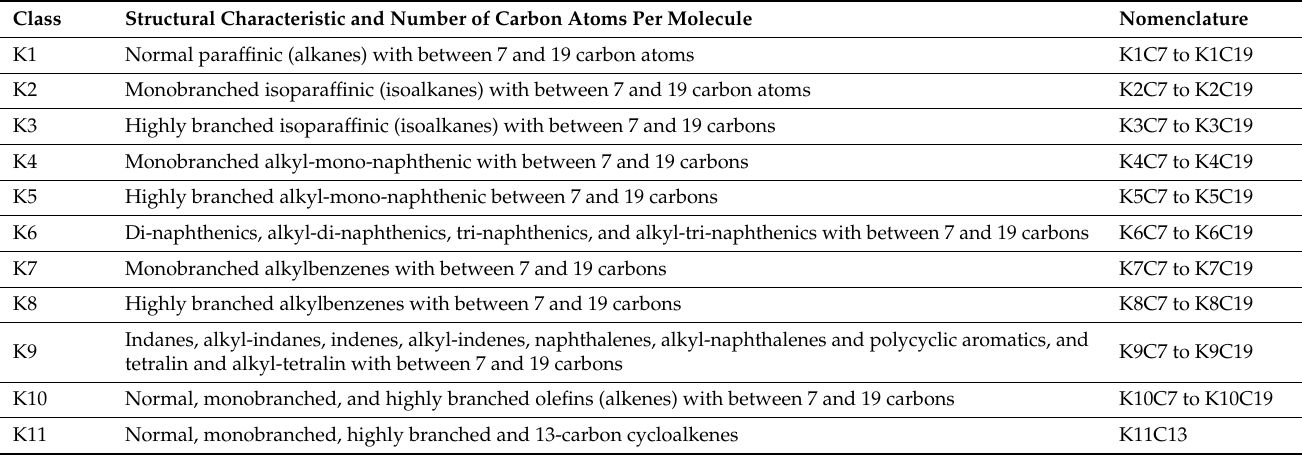
Table 1. Grouping of fuel components by carbon number and structural